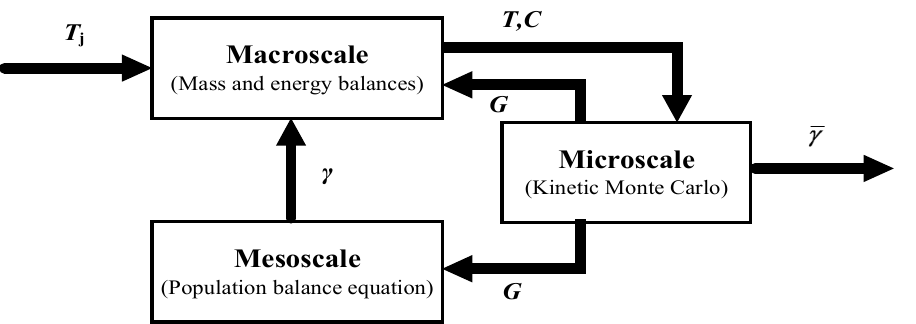
Figure 1. Multiscale scheme of the crystallization model.